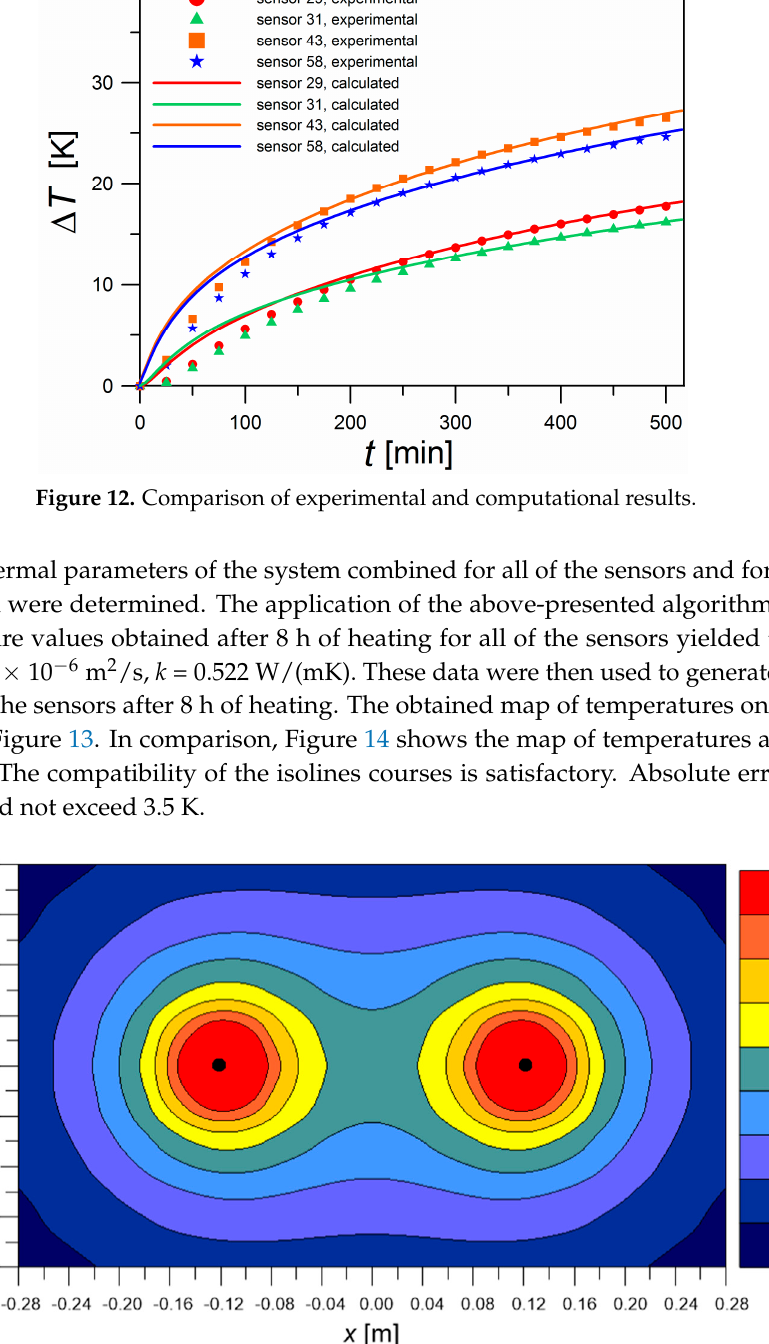
Figure 13. Temperature maps on the x - y plane determined on the basis of theoretical calculations.